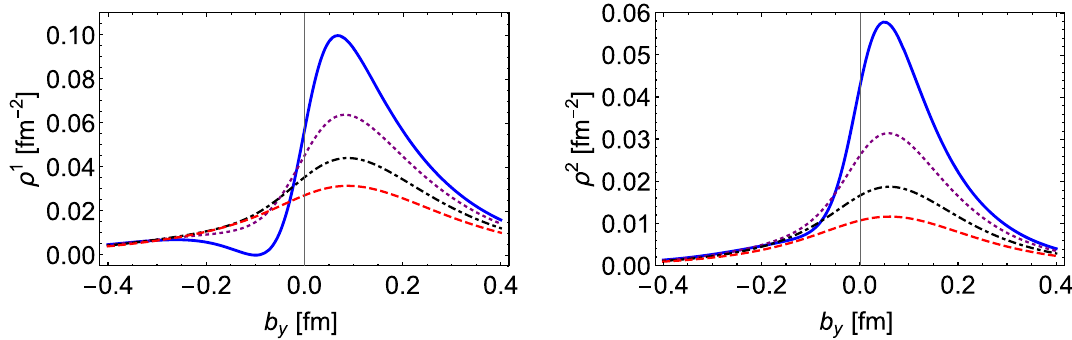
Fig. 9 The light-front transverse-spin distribution ρ 1 u ( b ⊥ , s ⊥ ) and ρ 2 u ( b ⊥ , s ⊥ ) , s ⊥ = ( 1 , 0 ) at constant b x fm: b x = 0 . 1 fm–blue solid curve, b x = 0 . 15 fm – purple dotted curve, b x = 0 . 2 fm–black dot-dashed curve, b x = 0 . 25 fm – red dashed